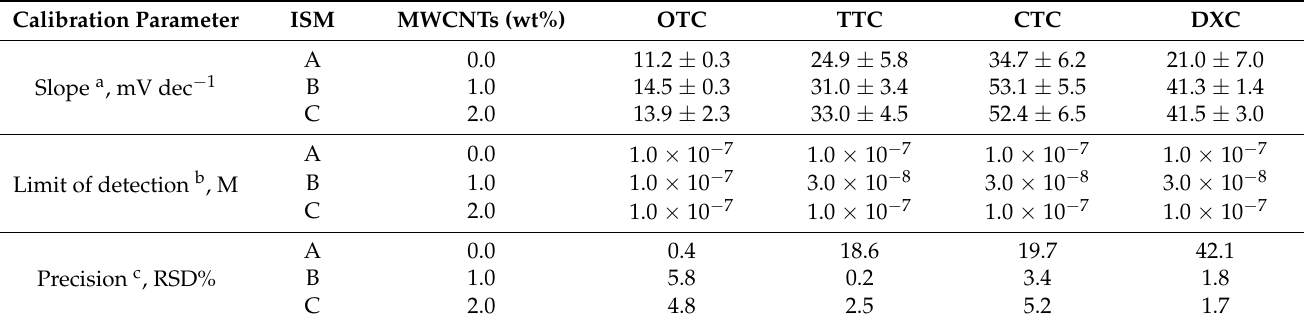
Table 3. Effect of the incorporation of MWCNTs in the analytical performance of the miniaturized TC-selective electrodes coupled in the HPLC